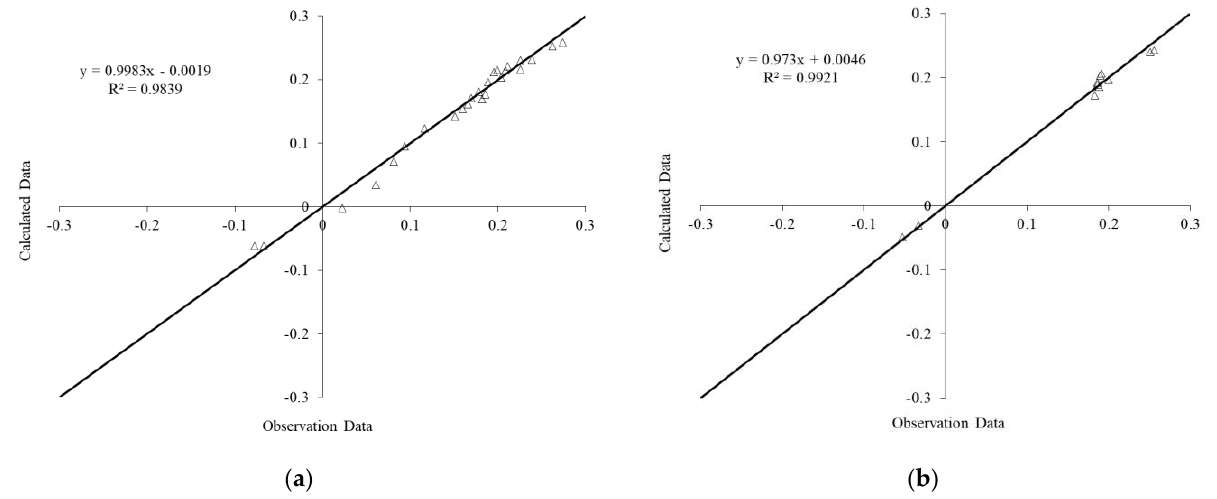
Figure 18. Predicted versus Experimental values of degree of damage output using ( a ) training data, ( b ) testing data.